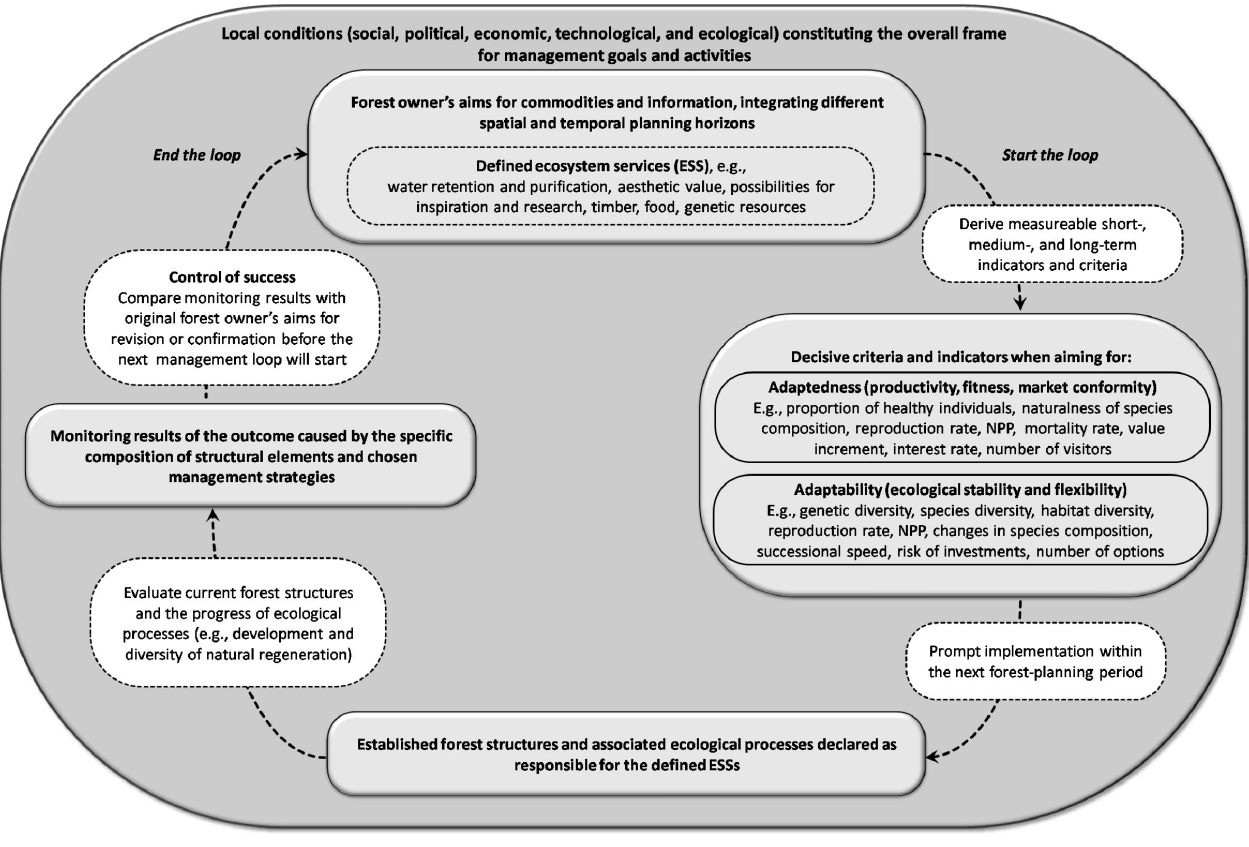
Fig. 1 . The goal-structure management loop. The forest owner aims for the provision of goods and services. This would demand a specific forest structure to best serves the intended goals. The specific environment of the forest enterprise, e.g., soil and climate, may not fit to this initial idea of a specific forest structure. Thus, the initial idea of forest structure has to be modified. Depending on whether the environment is taken as a static (certain) or a dynamic (uncertain) one, the modification will aim for adaptedness (static/ certain) or adaptability (dynamic/uncertain), each leading to a different forest structure. The final forest structure then determines the degree/amount of provision of the goods and services aimed for (broken